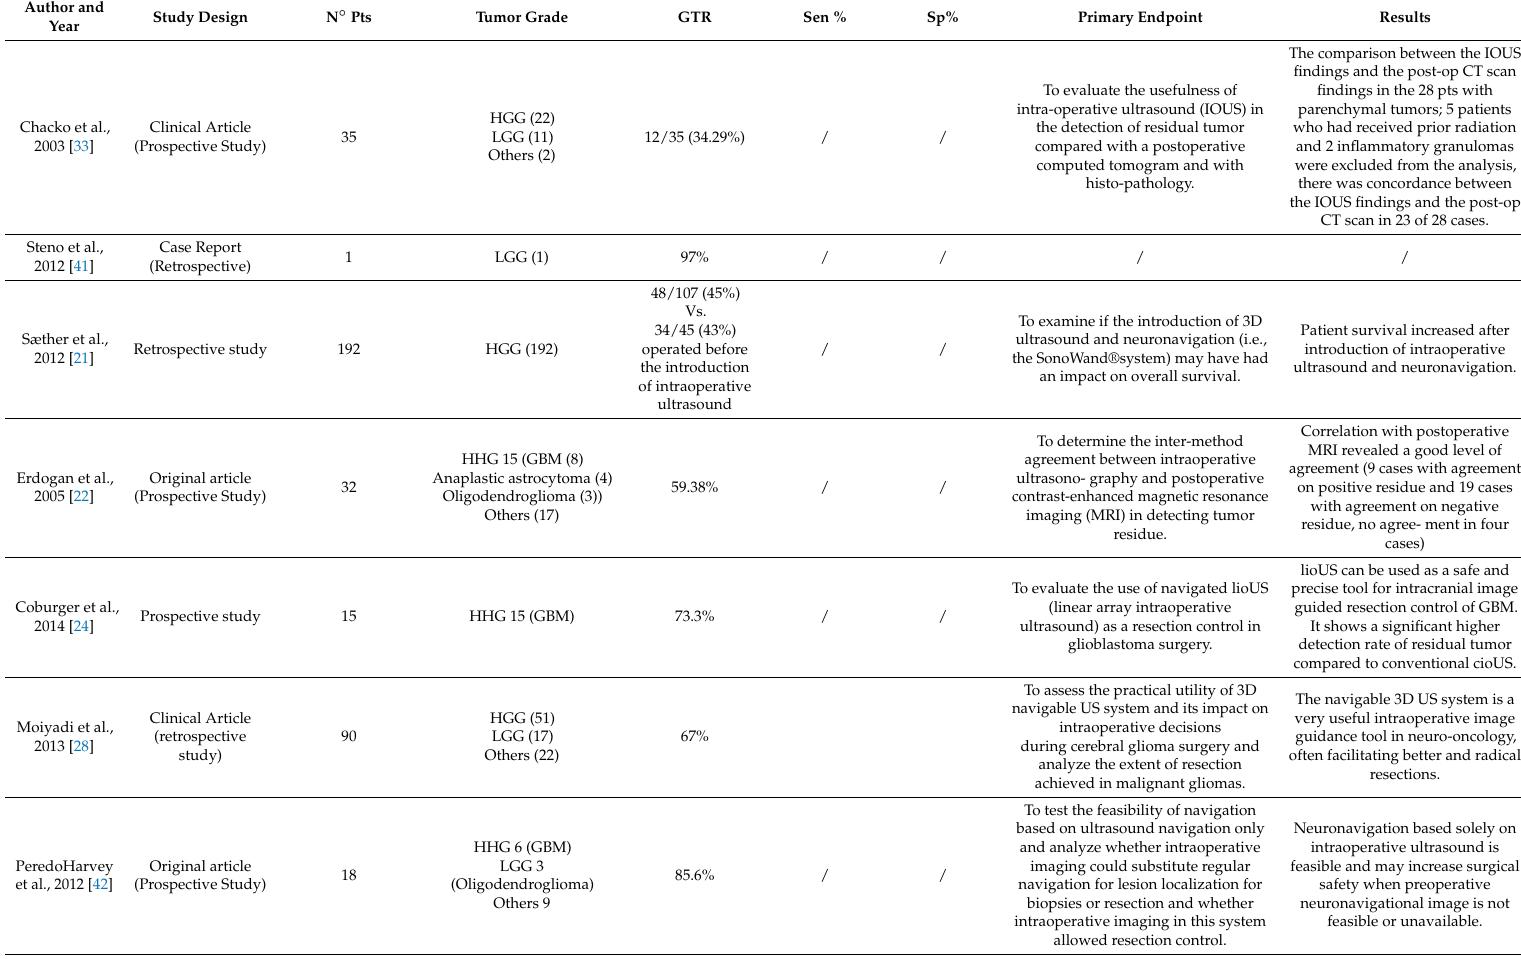
Table 1. Summary of the reviewed